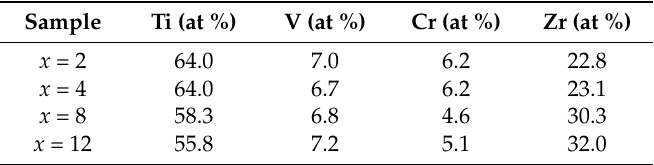
Table 3. EDX analysis showing the elemental composition of the secondary phase 1 (point 2) of